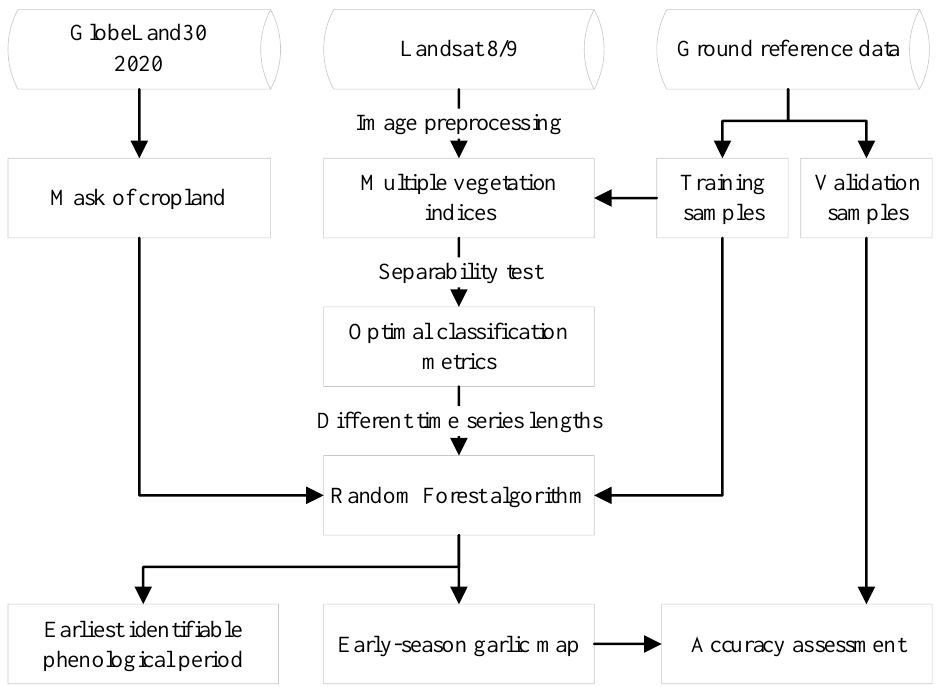
Figure 3. The algorithm framework for identifying and mapping garlic distribution.